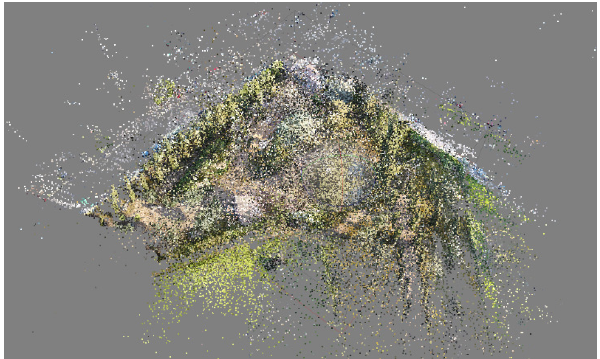
Figure 10. Sparse point cloud of the interior of the topography. Point cloud optimisation